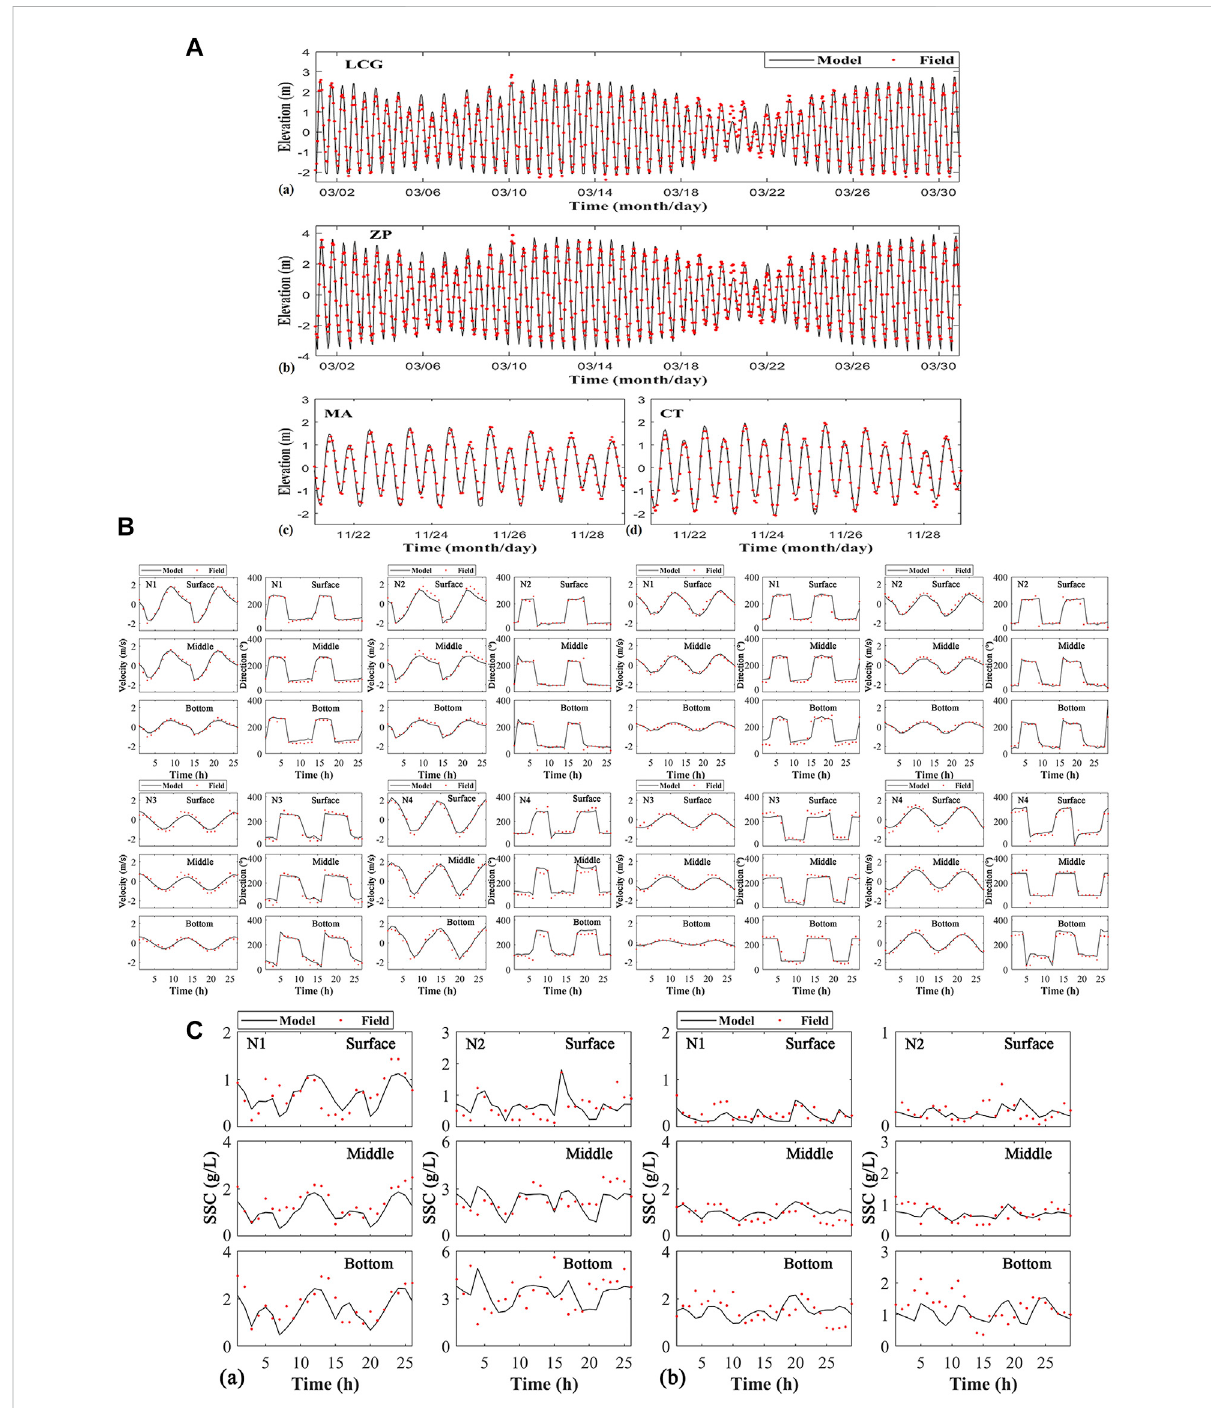
FIGURE 2 Model validation of (A) sea surfacelevel (a,b)2013, (c,b) 2014; (B) currents during spring tidesand neaptides,N1N2 weremeasured in2013 and N3 N4 were measured in 2014; (C) SSC (a) spring tides and (b) neap tides in